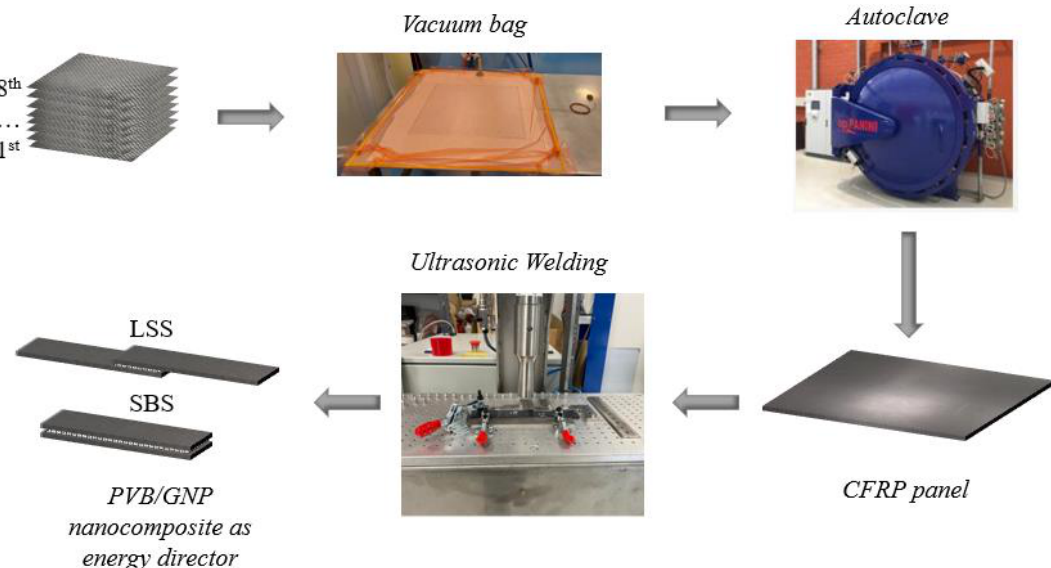
Figure 1. Fabrication process of CF/epoxy laminates and set-up of the ultrasonic welding process.